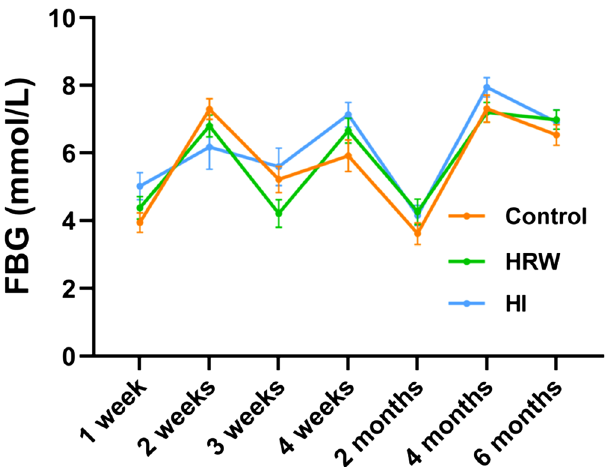
Figure 2. Effects of hydrogen treatment on fasting blood glucose. Values shown are mean ± SEM (n = 10). Figure was made with GraphPad Prism 8.0.2, https ://www.graph pad.com/suppo rt/faq/prism -802-relea se-notes .